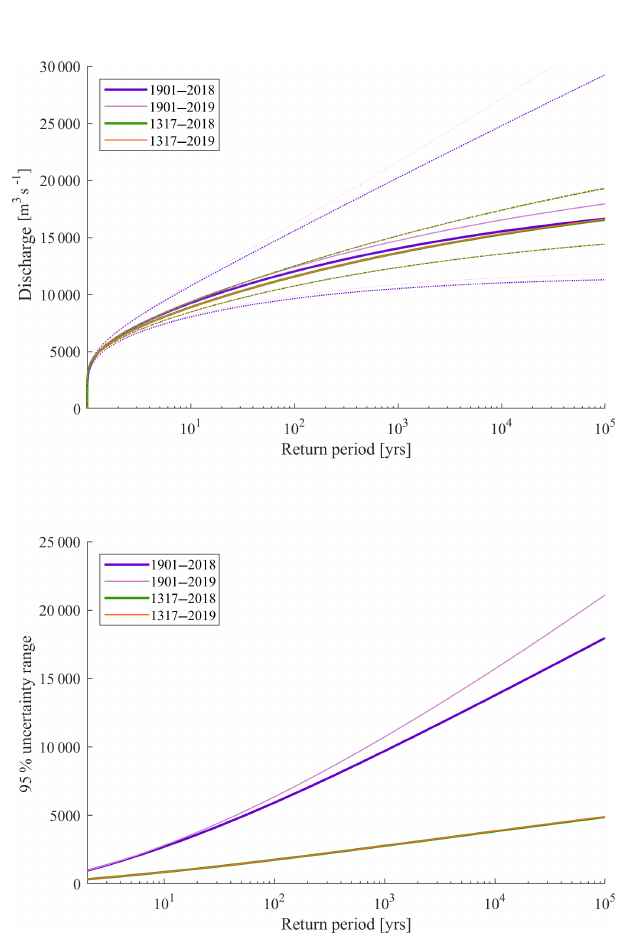
Figure 7. Fitted GEV curves and their 95% confidence intervals of the 1901 and 1317 data sets if they are extended with a future flood